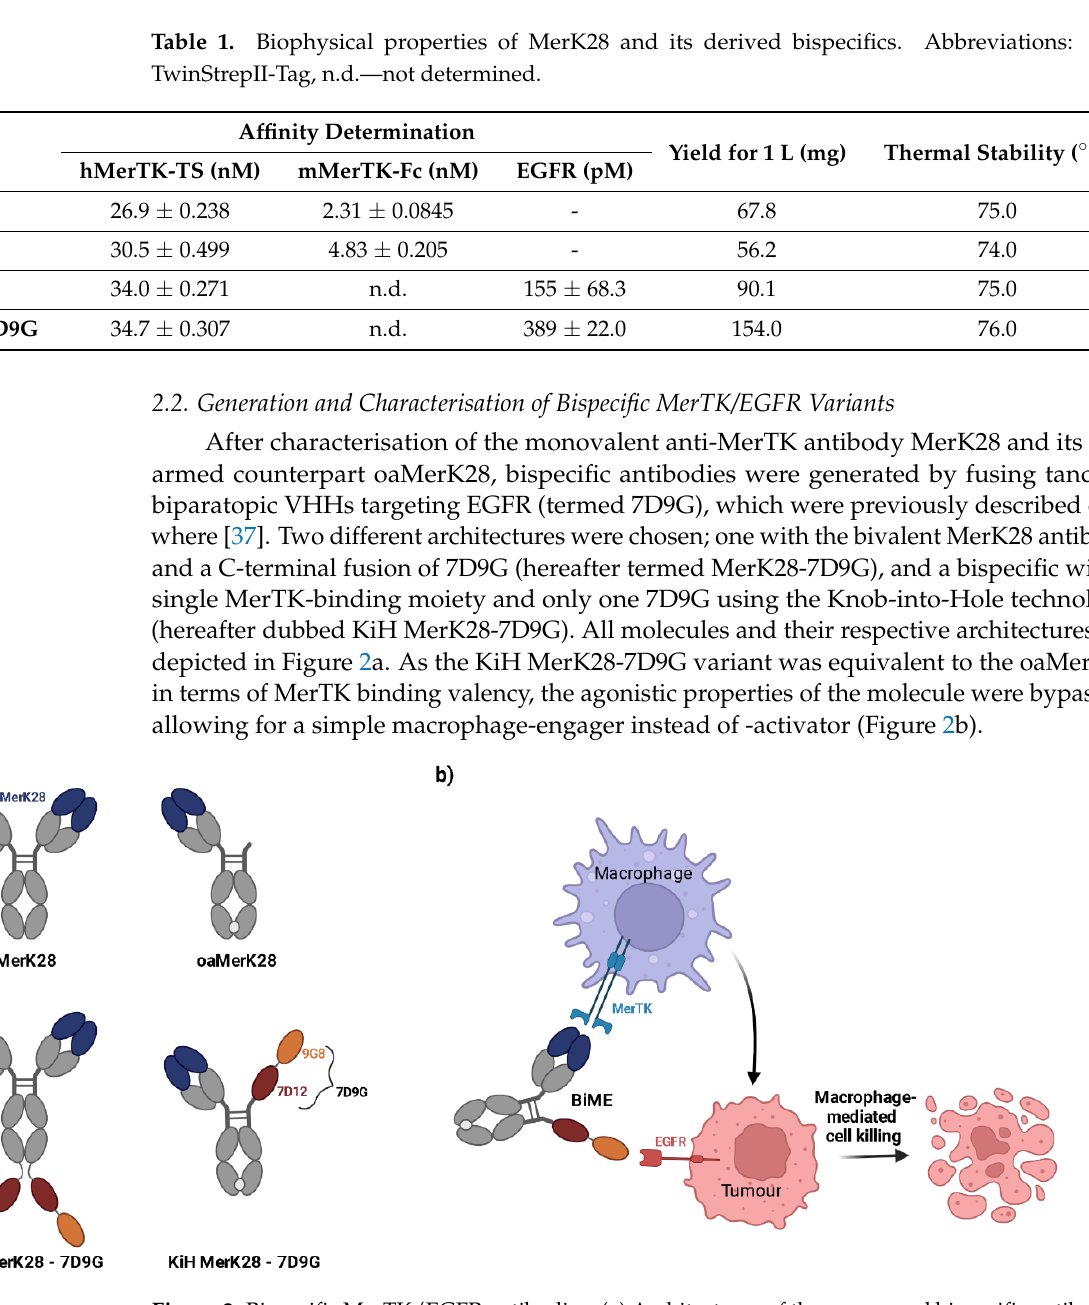
Figure 2. Bispecific MerTK/EGFR antibodies. ( a ) Architectures of the mono- and bispecific antibodies. VH and VL domains depicted in blue represent those for MerK28. The tandem VHHs together are termed 7D9G, with the red representing 7D12 and the orange 9G8 nanobodies. ( b ) Macrophage- tumour cells engagement with a bispecific macrophage engager (BiME). The blue cell represents macrophages expressing MerTK on their surface, whereas the pink cells represent tumour cells overexpressing EGFR.